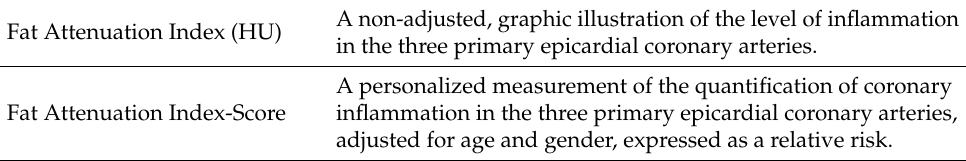
Table 3. The interpretation of FAI (HU) and